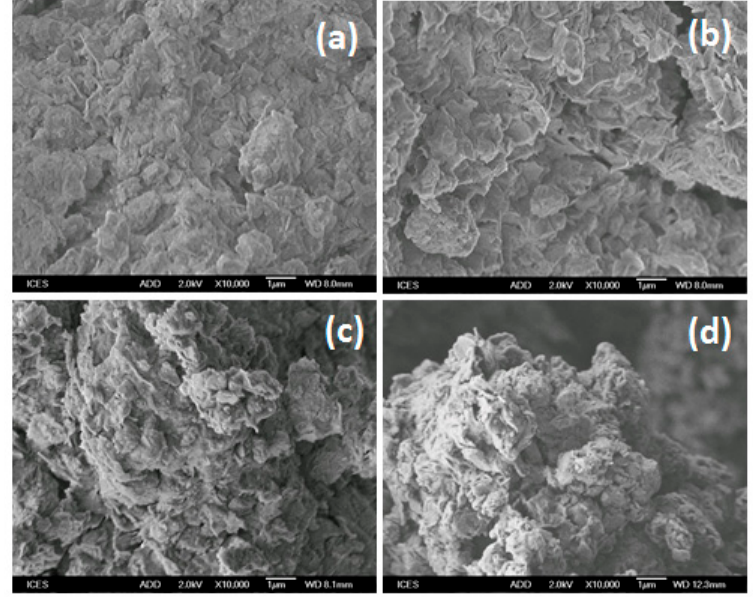
Figure 8. SEM micrographs of ( a ) cloisite Na exchanged with C 16 solutions. ( b ) C 16 Br, ( c ) C 16 Cl, and ( d ) C 16 OH solutions.